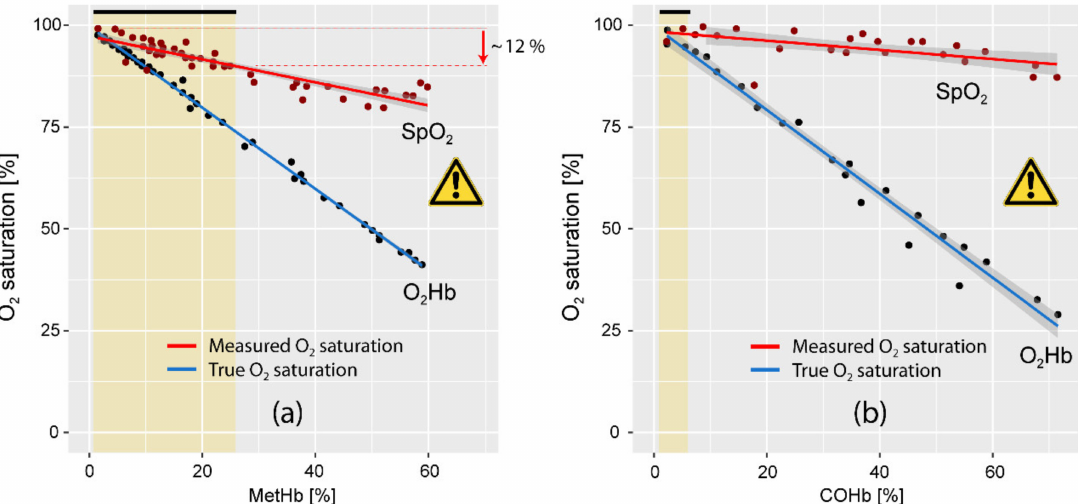
Figure 4. The impact of MetHb and COHb on SpO 2 measured with pulse oximetry. ( a ) Blood MetHb vs. SpO 2 and blood Hb O 2 saturation (O 2 Hb). Data extracted from Barker et al. [86]. ( b ) Blood COHb vs. SpO 2 and blood O 2 Hb saturation. Data extracted from Barker et al. [87]. In both studies, measurements were made on dogs; the inspired O 2 fraction (FIO 2 ) was 1, SpO 2 was measured on the tongue with a pulse oximeter (Nellcor N-100, USA) and COHb, MetHb and O 2 Hb saturation with a CO-oximeter (IL-282, Instrumentation Laboratories, Bedford, MA, USA). The figures show data extracted from the original figures of the respective